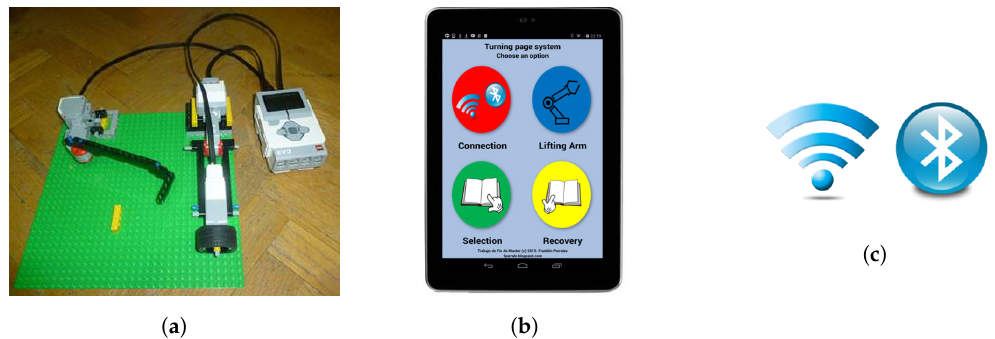
Figure 1. Components of this project. ( a ) Robotic arms; ( b ) Remote control system; ( c ) Bluetooth or Wi-Fi connectivity.